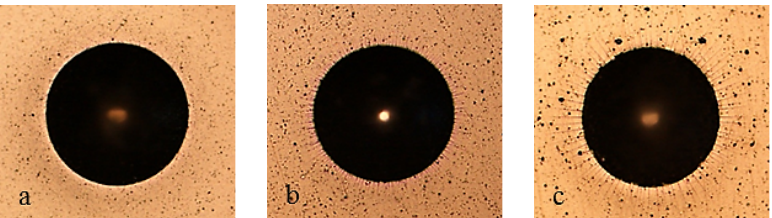
Figure 2. Rockwell indentation on X153CrMoV12 coated steel: ( a ) Monolayer; ( b ) Multilayer 4; ( c ) Multilayer